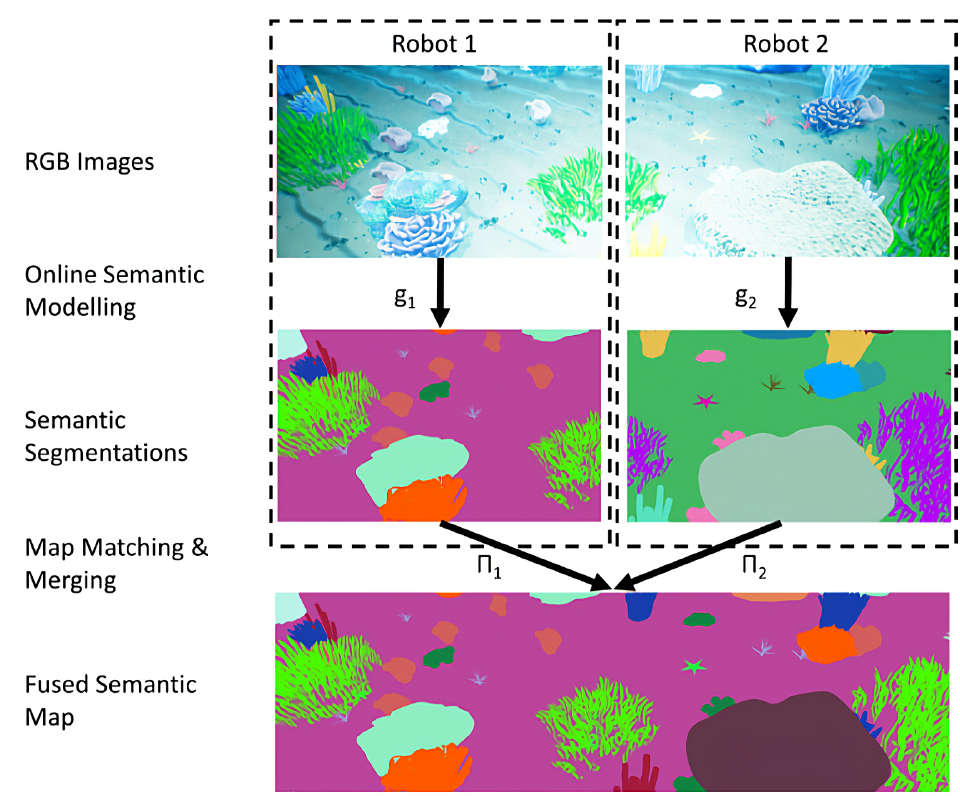
Figure 9. The fusion of two different semantic models developed by two robots in the same environ- ment